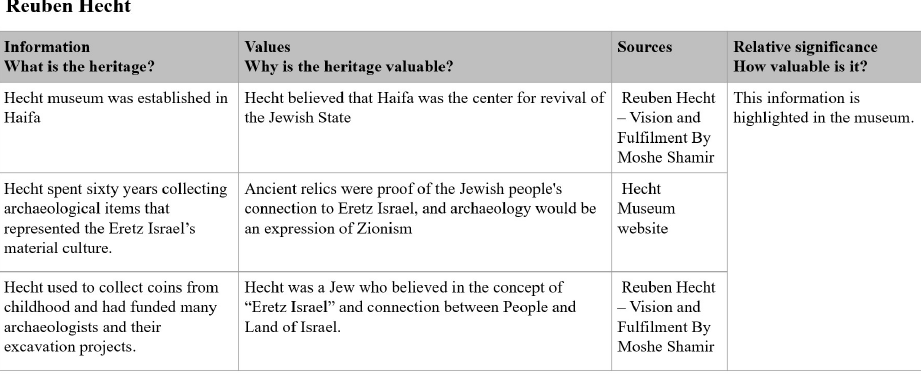
Figure 5. Content design structure showing the relative importance of the information and values associated with Dr. Reuben Hecht’s